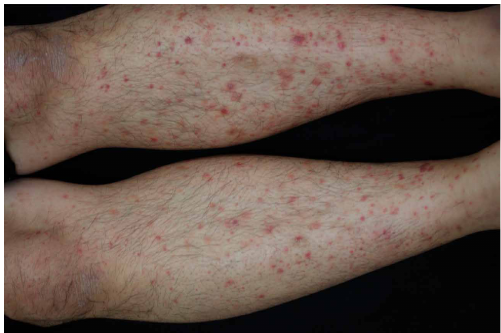
Figure 1: Purpuric rash on the patient’s lower extremities.